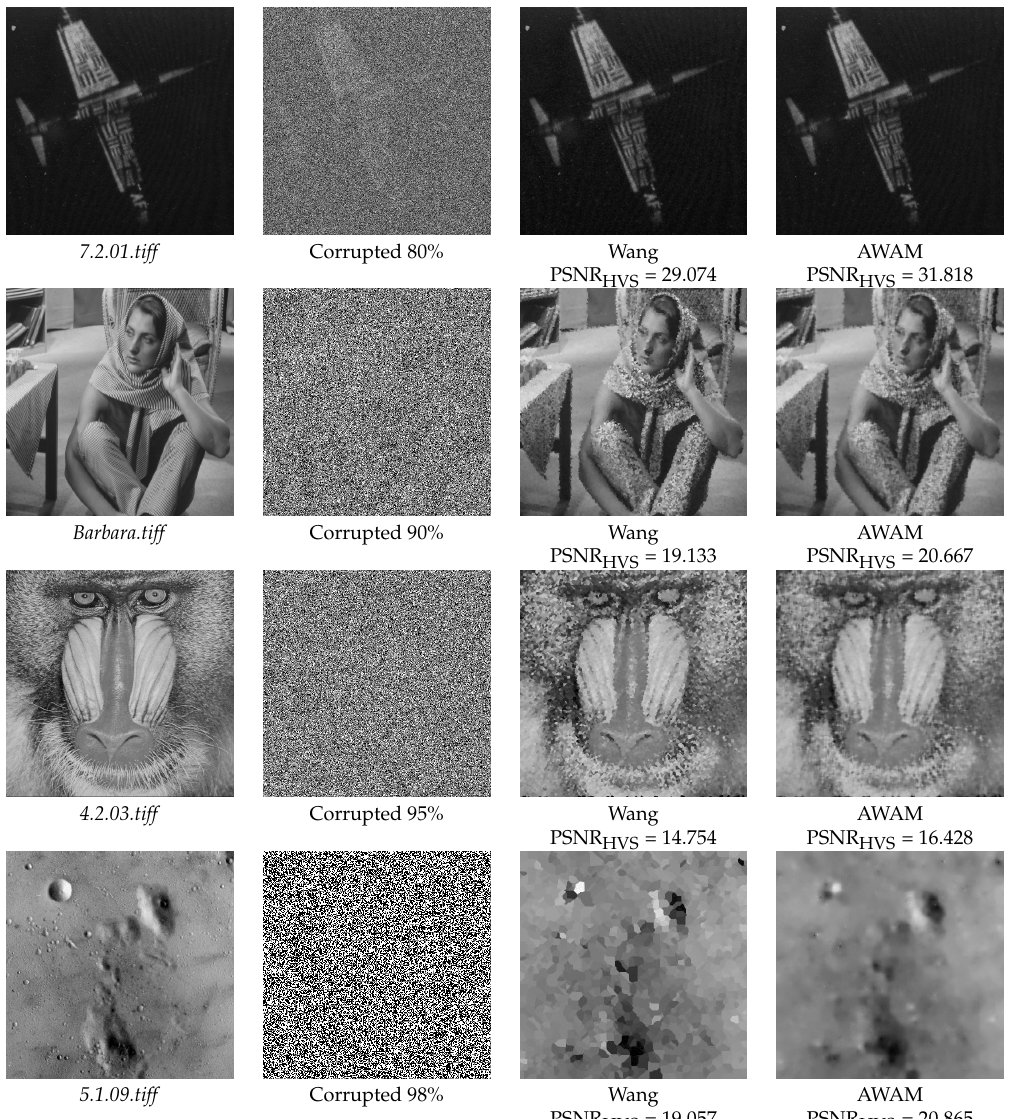
Figure 9. Restoration results of Wang and AWAM filters when applied to the original images shown in the first column, corrupted with high levels of salt-and-pepper